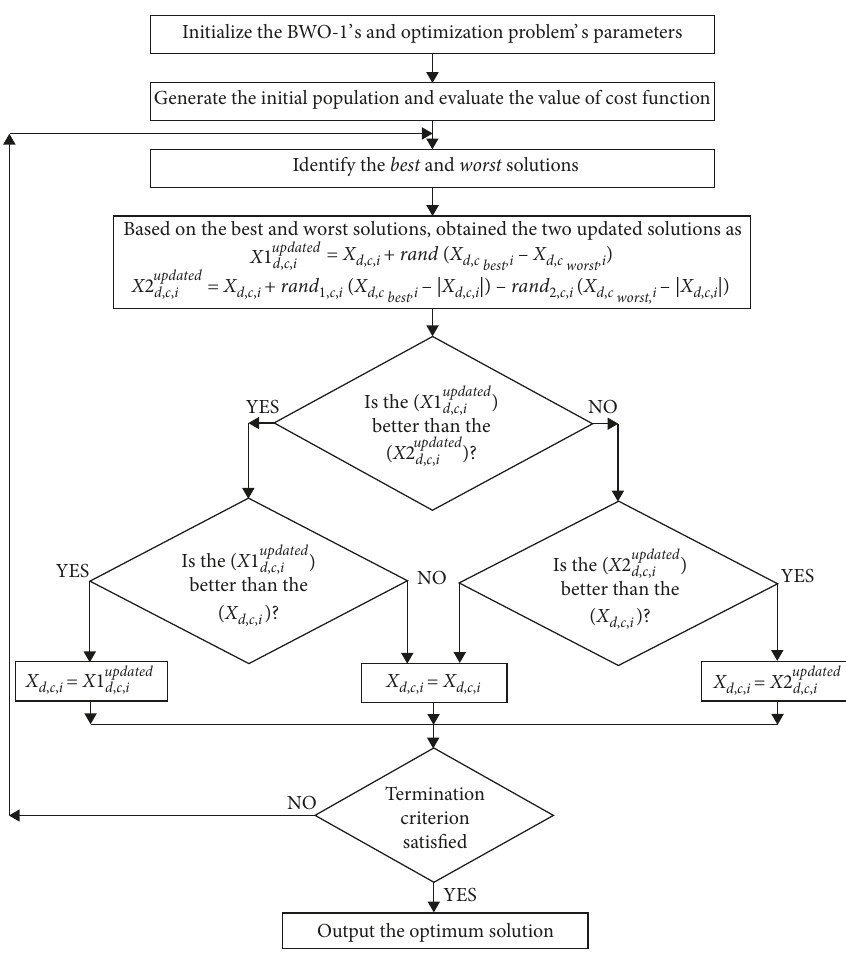
Figure 5: Flowchart of